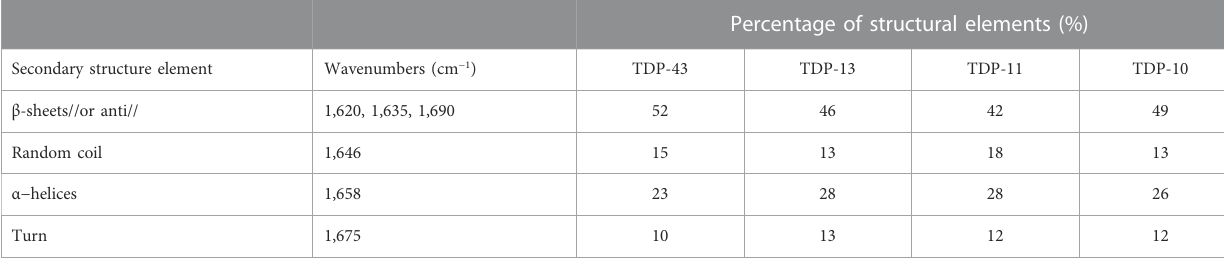
TABLE 1 Secondary structure content of TDP-43 CTF amyloid fi brils probed by ATR-FTIR